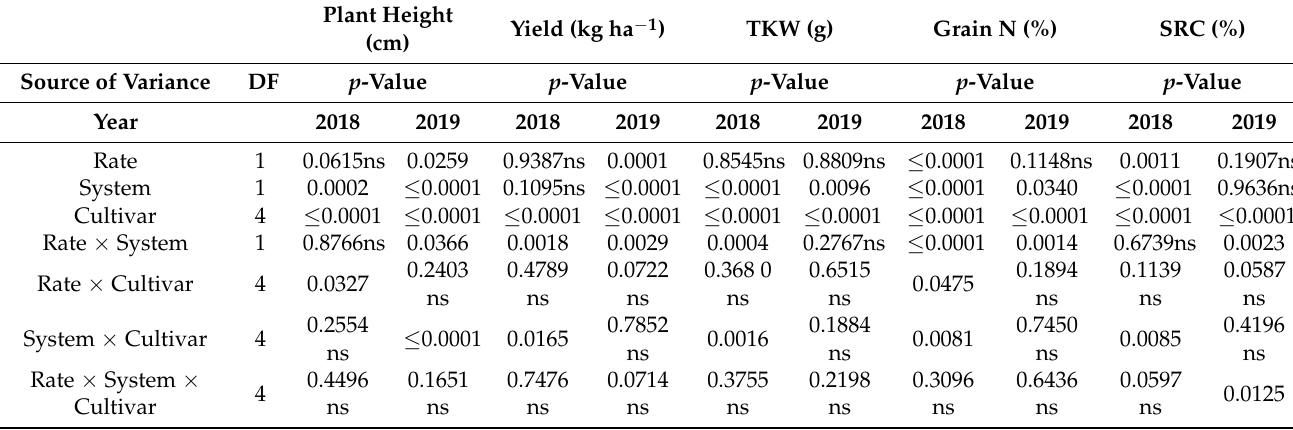
Table A1. ANOVA values for plant height (cm), 1000 kernel weight (TKW, g), yield (kg ha − 1 ), grain nitrogen (Grain N, %) and lactic acid (SRC, %). Values were considered significant at the α ≤ 0.05 level, with non-significant effects indicated by annotation as